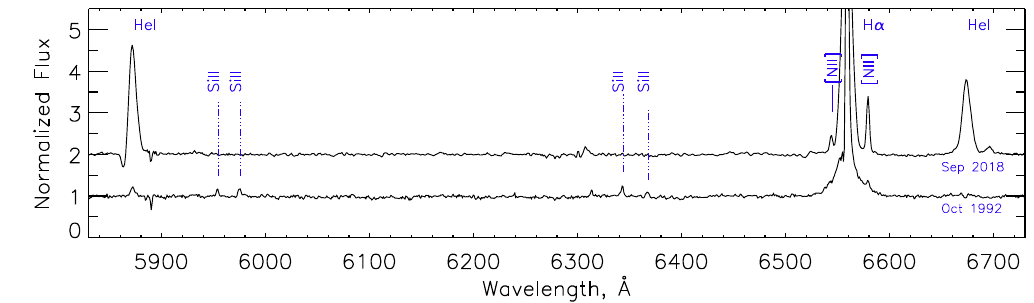
Figure 4. Comparison of normalized optical spectra of GR290 obtained with Calar Alto/TWIN in October 1992 by Szeifert [4] and with GTC/OSIRIS in September 2018. Spectra are displaced vertically for illustrative